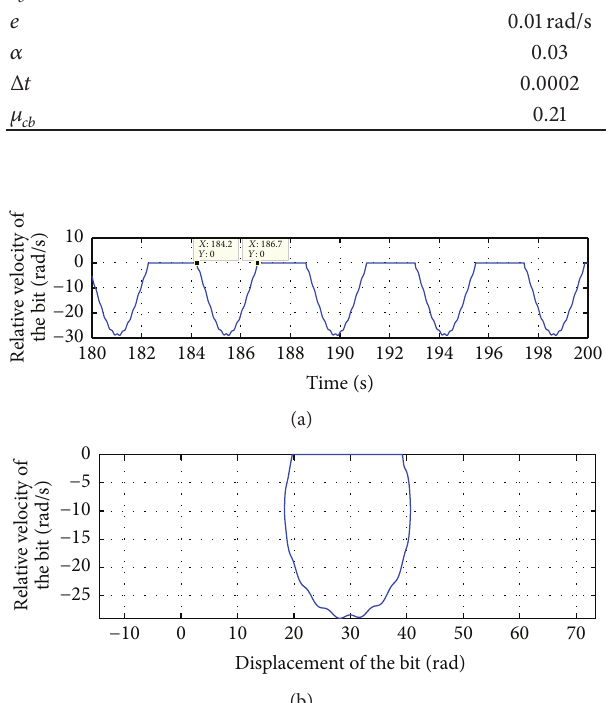
Figure 3: Stick-slip when the ground speed is 10rad/s: (a) time history; (b) phase